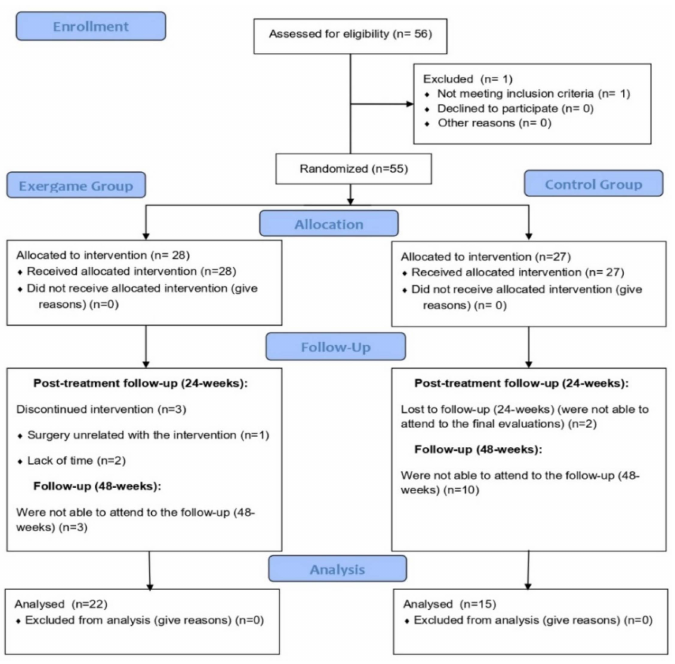
Figure 1. Flow chart of participants. Table 1. Demographic data and di ff erences between groups at